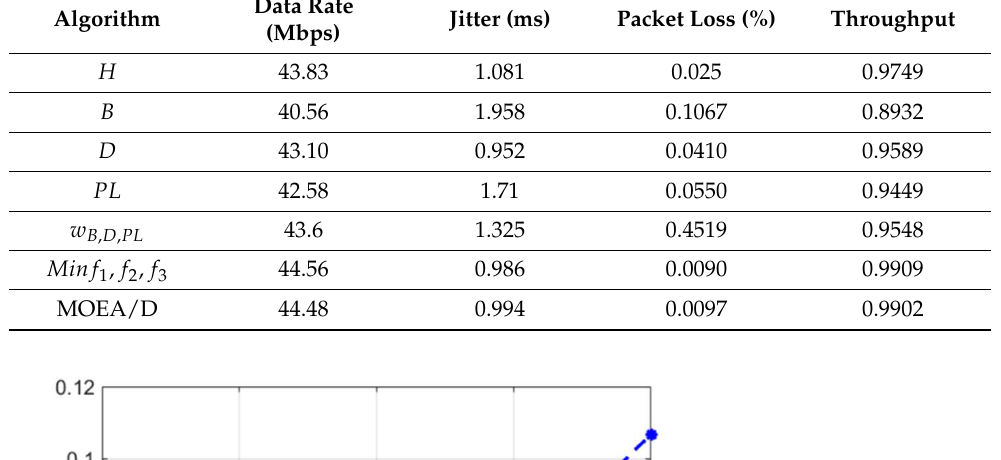
Table 6. Performance summary of UDP flow between H1 and H14.